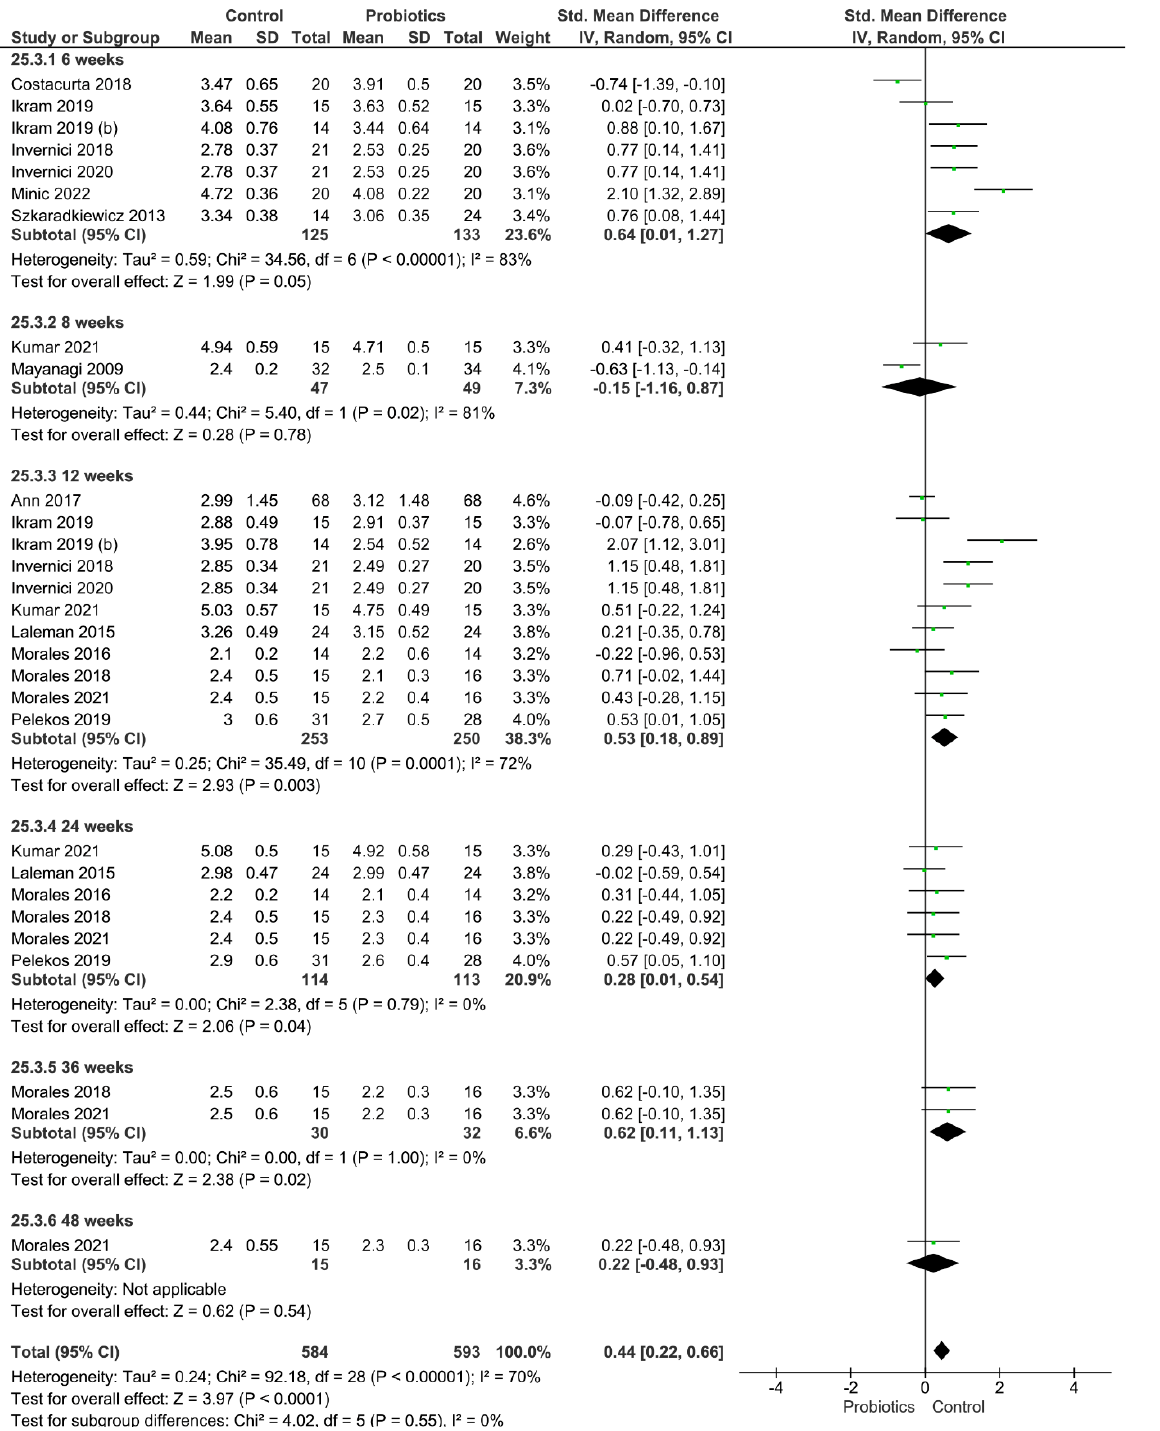
Figure 3. Results from the meta-analysis for the periodontal pocket depth parameter.